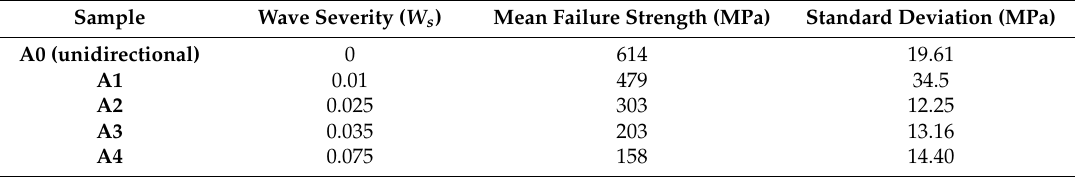
Table 4. Compression test results of composites with and without waviness defects.